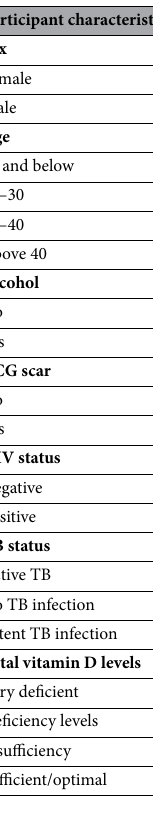
Table 2. Median differences in total vitamin D among participant characteristics. IQR is interquartile range, vitamin D levels are in ng.ml and p value < 0.05.